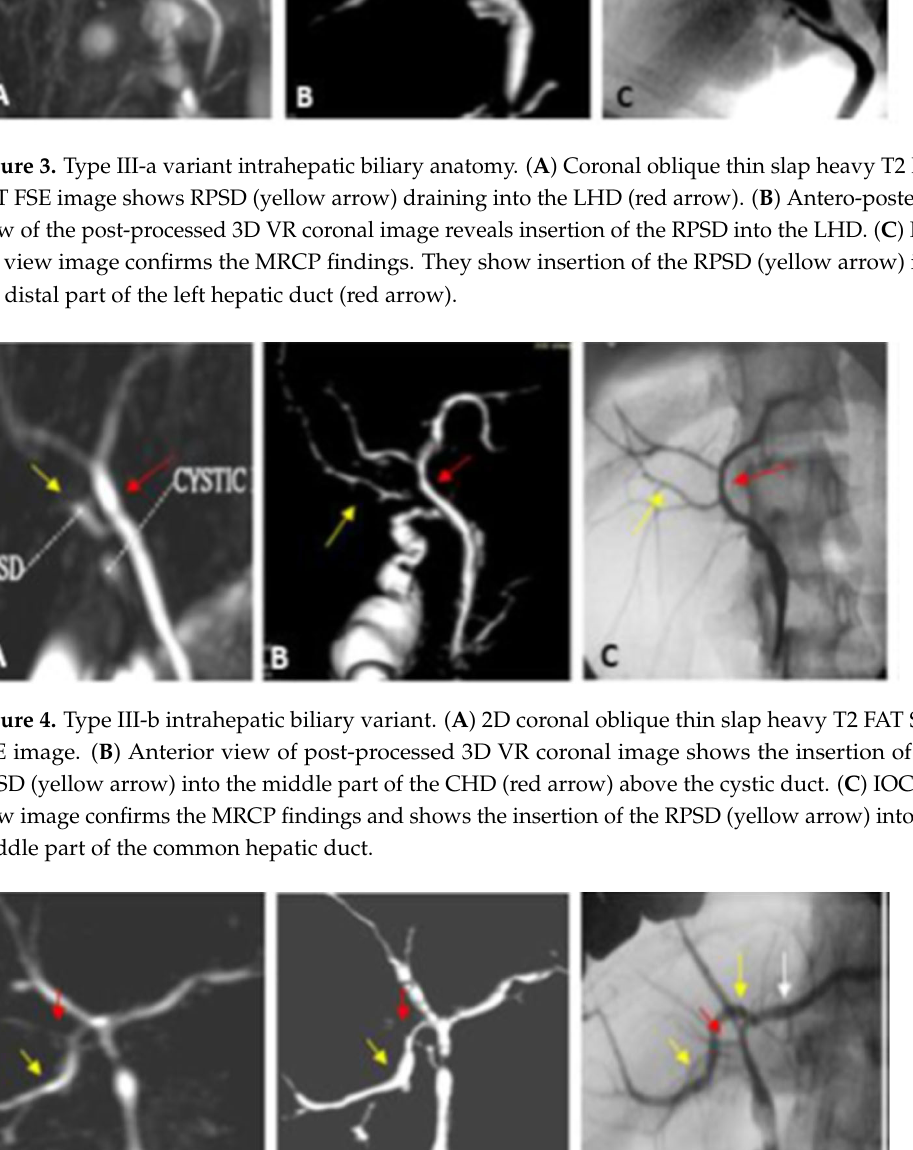
Figure 5. Type VII unclassified intrahepatic biliary variant. ( A ) Oblique view of post-processed coronal 2D (MIP) image. ( B ) Anterior view of post-processed 3D VR coronal image shows the RPSD (yellow arrow) draining into the confluence of the RHD and LHD (reported as trifurcation). Small right accessory duct (red arrow) draining into the proximal part of the common hepatic duct. ( C ) The IOC AP view image shows the insertion of the RPSD (yellow arrows) into the distal end of the left hepatic duct (white arrow). The small right accessory bile duct (red arrow) is seen draining into the proximal common hepatic duct.